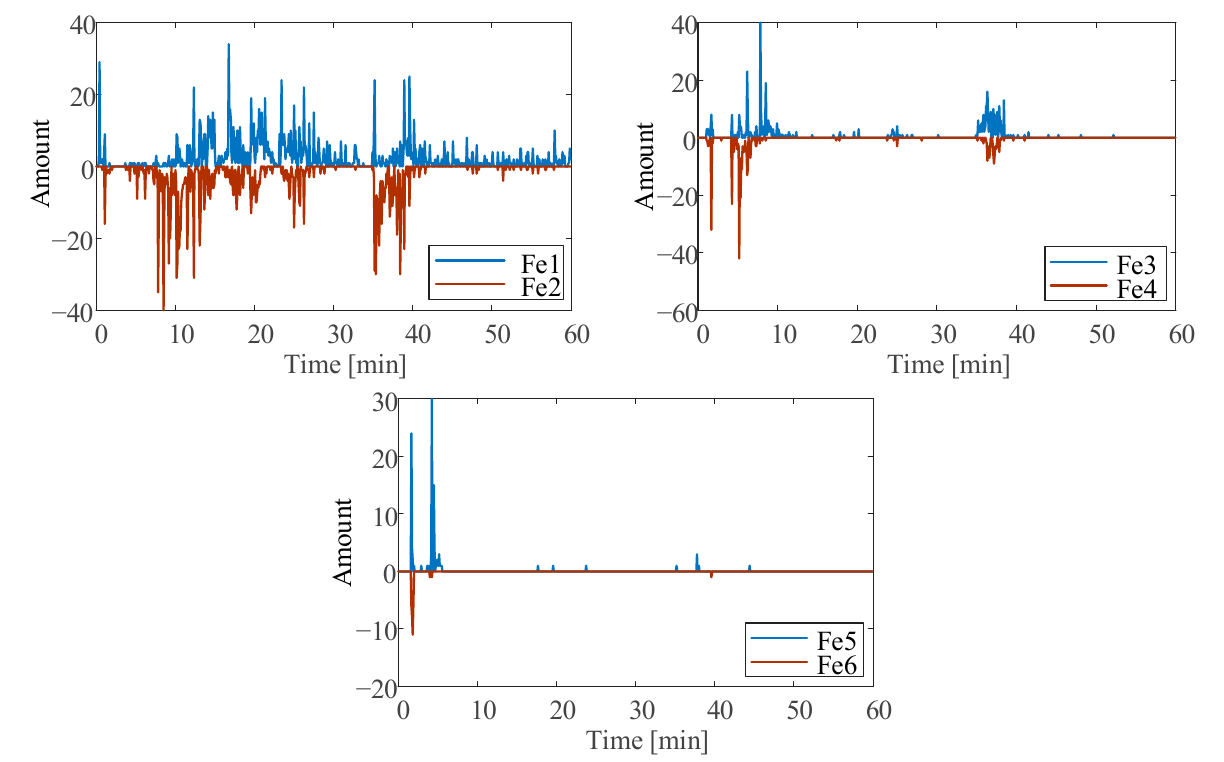
Figure 10. Ferrous oil debris particle amount at abrasive wear.